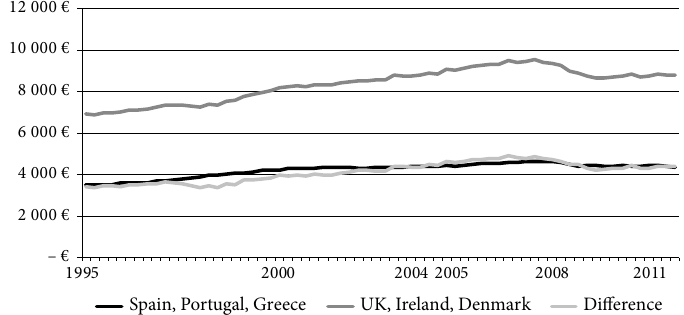
Fig. 8. Convergence in GDP per capita of UK, Ireland, Denmark vs. Spain, Greece and Portugal Source : own results.